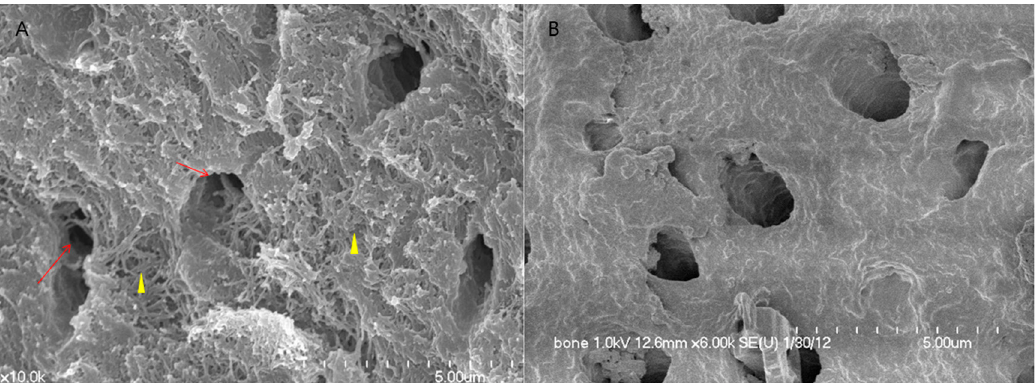
Figure 1. SEM image of DDM. ( A ) Surface of DDM. Cross-sectioned tubules showing exposed outer peritubular (arrow) and intertubular collagen fibrils (arrowhead) after demineralization; ( B ) Surface of DDM/rhBMP-2. rhBMP-2 (0.2 mg/mL, Cowell BMP, Busan, Korea) was fixed to DDM. Structurally,